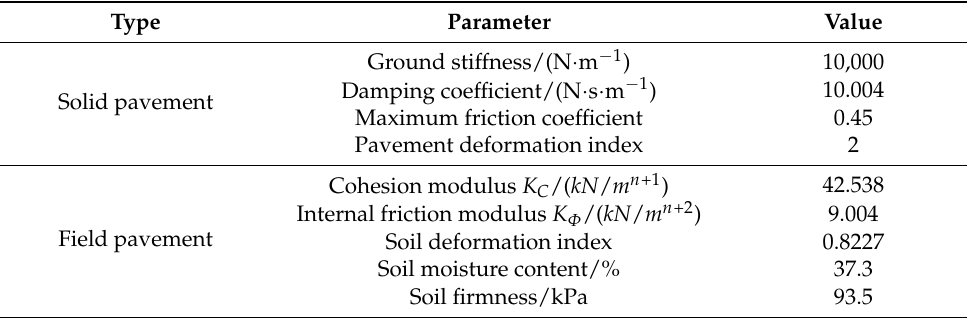
Table 4. Main parameters of ground.